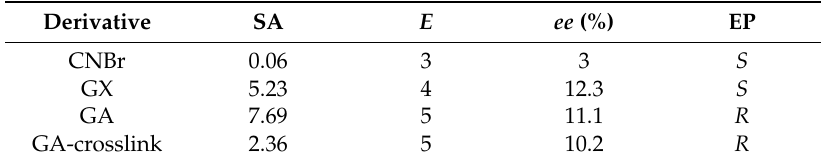
Table 5. Activity and enantioselectivity of lipase derivatives in the hydrolysis of racemic -Butyryl- 2-phenylacetic